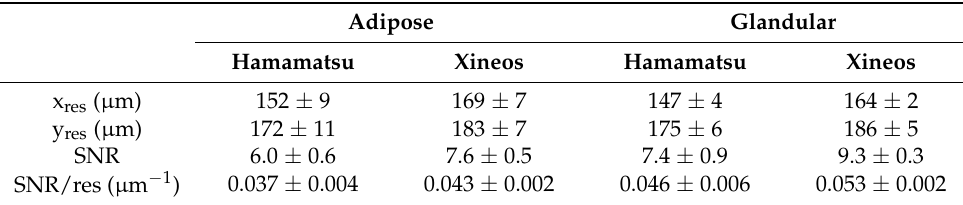
Table 2. Measured spatial resolution, SNR, and SNR/res for the PCT images produced using data from the Hamamatsu and the Xineos detectors, respectively, of the adipose and glandular tissues in a mastectomy sample scanned at 32 keV (6 m sample-detector distance, MGD = 4 mGy). Adipose Glandular Hamamatsu Xineos